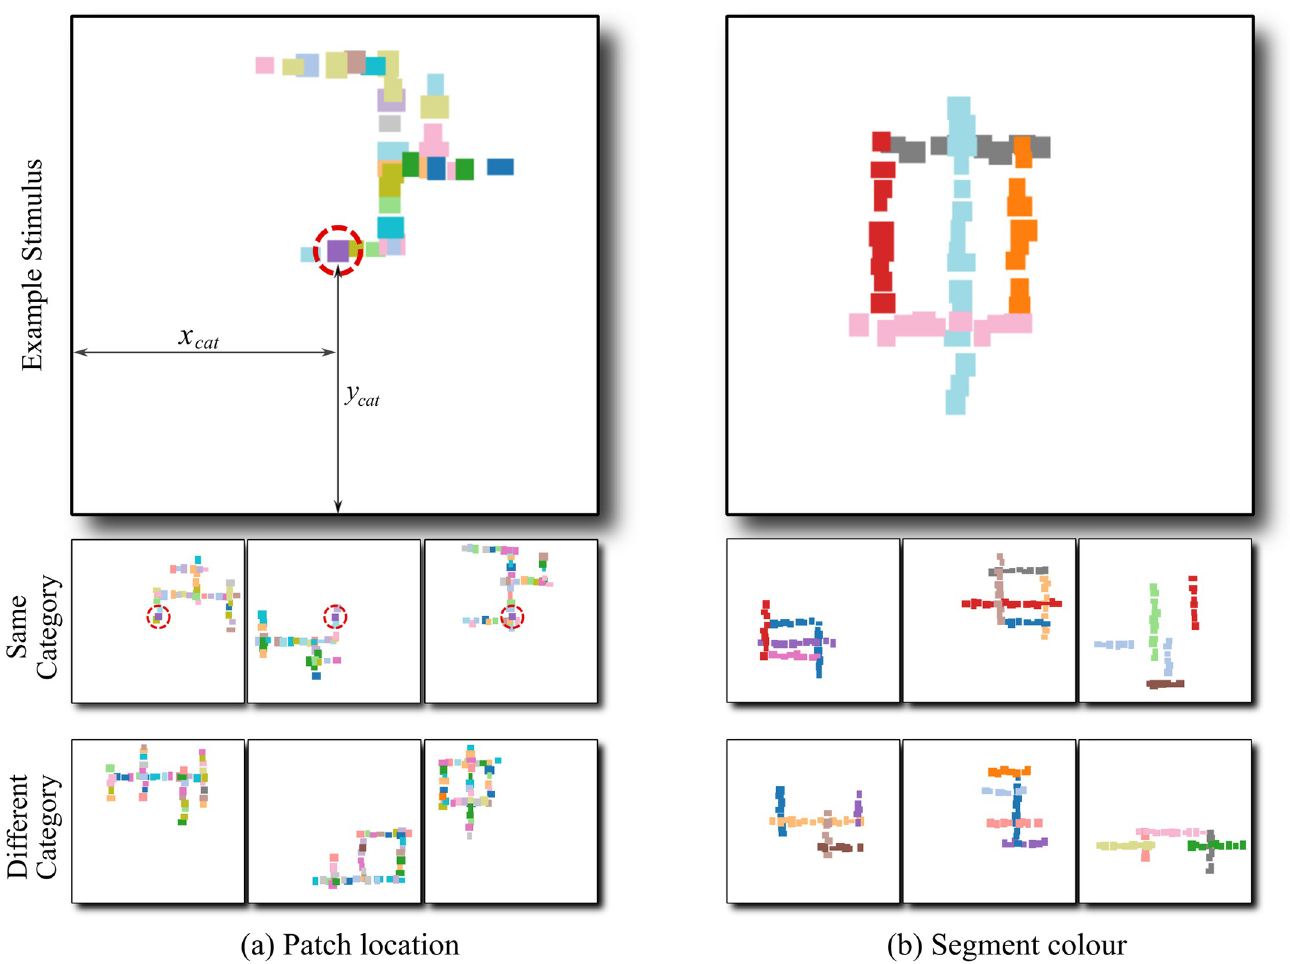
Fig 1. Example training images from Experiments 1 and 2. (a) Two features predict stimulus category: global shape and location ( x cat , y cat ) of one of the patches. For illustration, the predictive patch is circled. Stimuli in the same category (middle row, reduced size) have a patch with the same colour at the same location, while none of the stimuli in any other category (bottom row) have a patch at this location. (b) Global shape and colour of one of the segments predict stimulus category. Only stimuli in the same category (middle row) but not in any other category (bottom row) have a segment of this colour (red). The right-most stimulus in the middle row shows an example of a training image containing a non-shape feature (red segment) but no shape feature. For further illustration of stimuli used in these and other experiments, see S9–S13 Figs and S1 and S2 Movies.